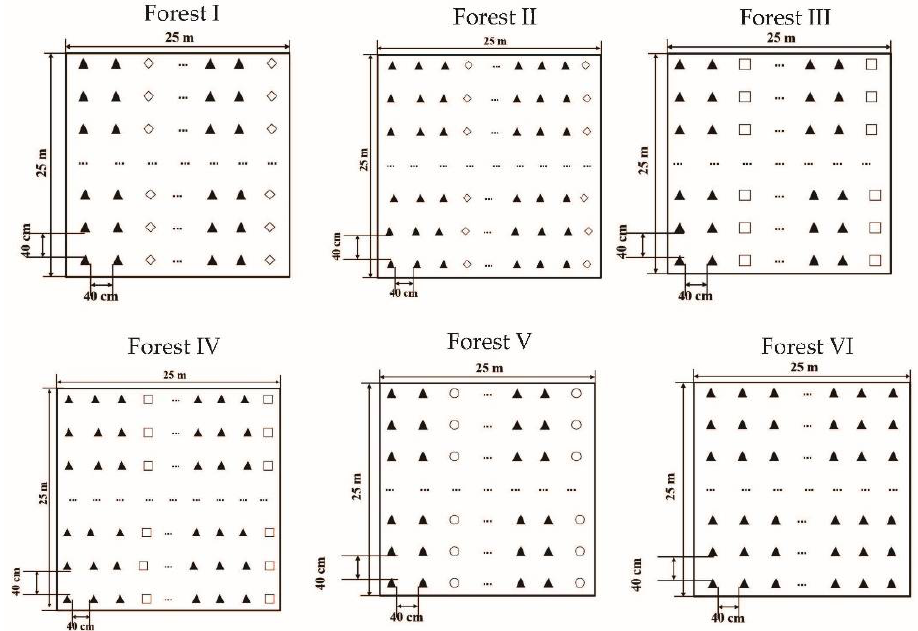
Figure 1. Area settings. Forest I: Pinus yunnanensis × Alnus nepalensis (2:1); Forest II: Pinus yunnanensis × Alnus nepalensis (3:1); Forest III: Pinus yunnanensis × Quercus acutissima (2:1); Forest IV: Pinus yunnanensis × Quercus acutissima (3:1); Forest V: Pinus yunnanensis × Celtis tetrandra (2:1); Forest VI: Pinus yunnanensis pure forest. ▲ : Pinus yunnanensis ; ◊: Alnus nepalensis ; □: Quercus acutissima ; ○ : Celtis tetrandra , hereinafter the same. Table 1. Basic information of experimental plots. Forest Stands